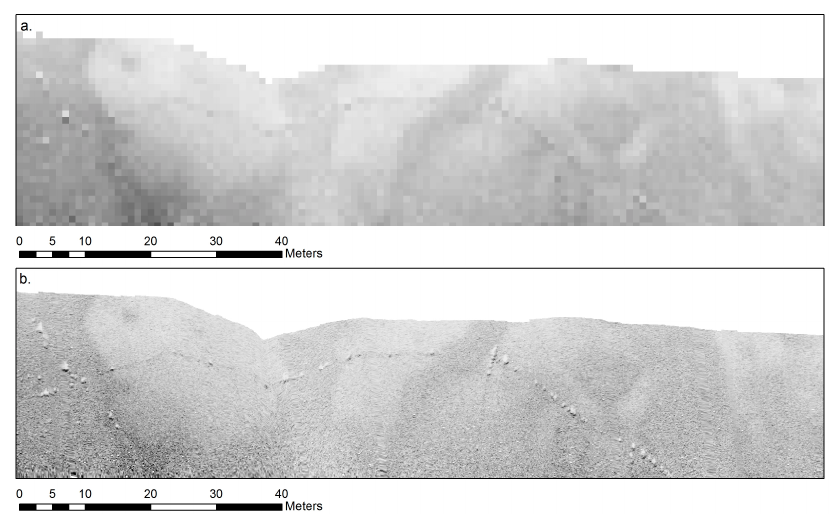
Figure 10. Comparison in backscatter resolution ( a ) 1 m resolution and ( b ) 5 cm resolution. The fine scale brine drainage channels are not clearly visible at 1 m resolution, but when the data is presented at 5 cm resolution the brine drainage channels can be clearly identified.